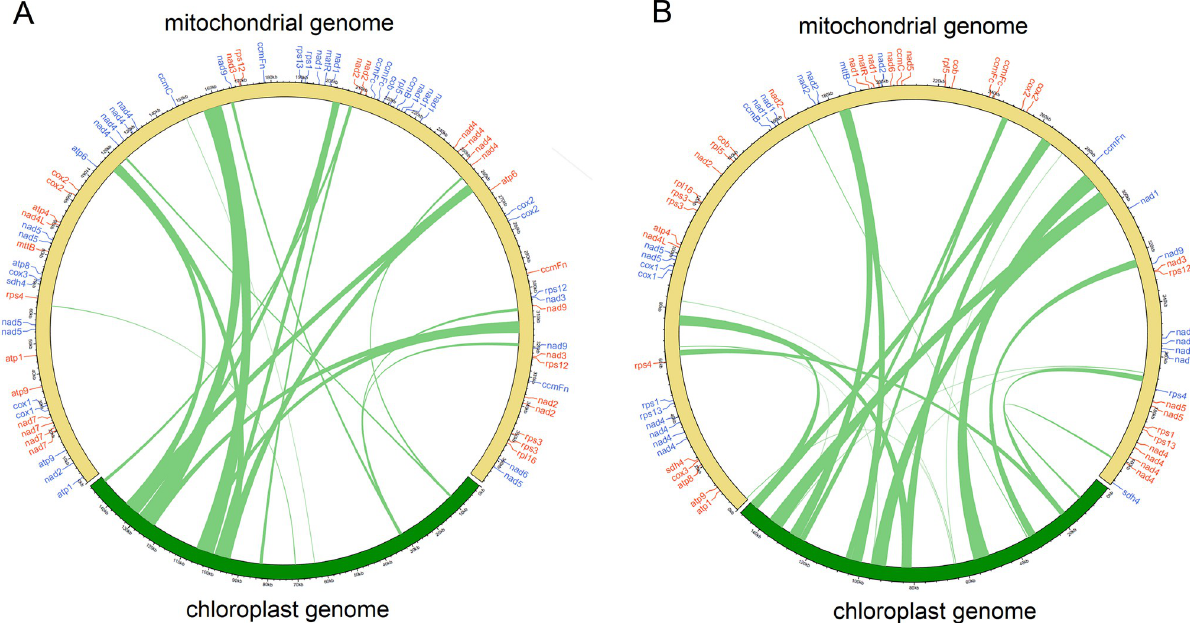
Fig 7. Gene exchange in chloroplast genome and mitochondrial genome of Gentiana crassicaulis (A) and G . straminea (B). The green lines within the circle show the regions of the chloroplast genome those have been inserted into different locations of the mitochondrial genome.